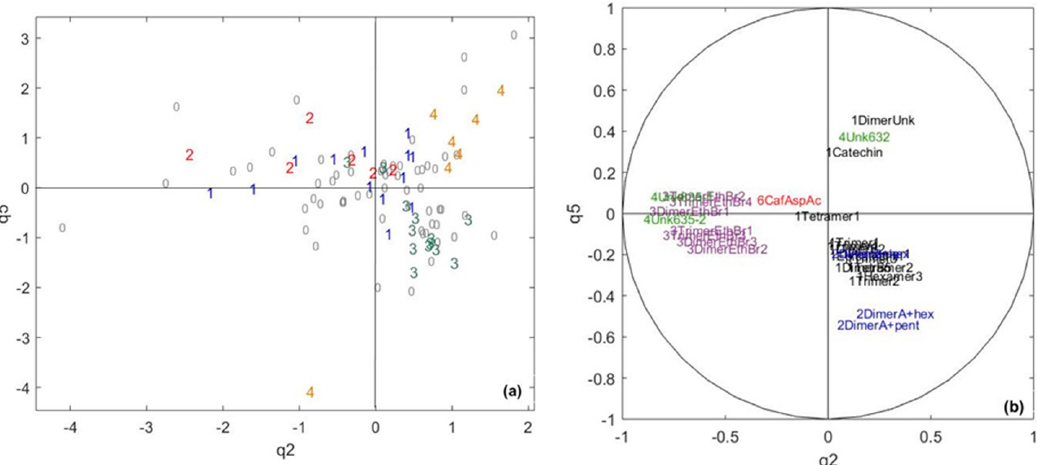
Figure 6. The CCSWA on the chocolate and cocoa data, a cocoa-specific space: ( a ) score plot. 1 = core pole 1, 2 = core pole 2, 3 = core pole 3, 4 = core pole 4 and 0 = samples not belonging to any core pole. ( b ) Correlation circle. Black = flavan-3-ols, blue = glycosylated flavan-3-ols, purple = ethyl-bridged flavan-3-ols, green = unknown compounds and red = hydroxycinnamic acid.